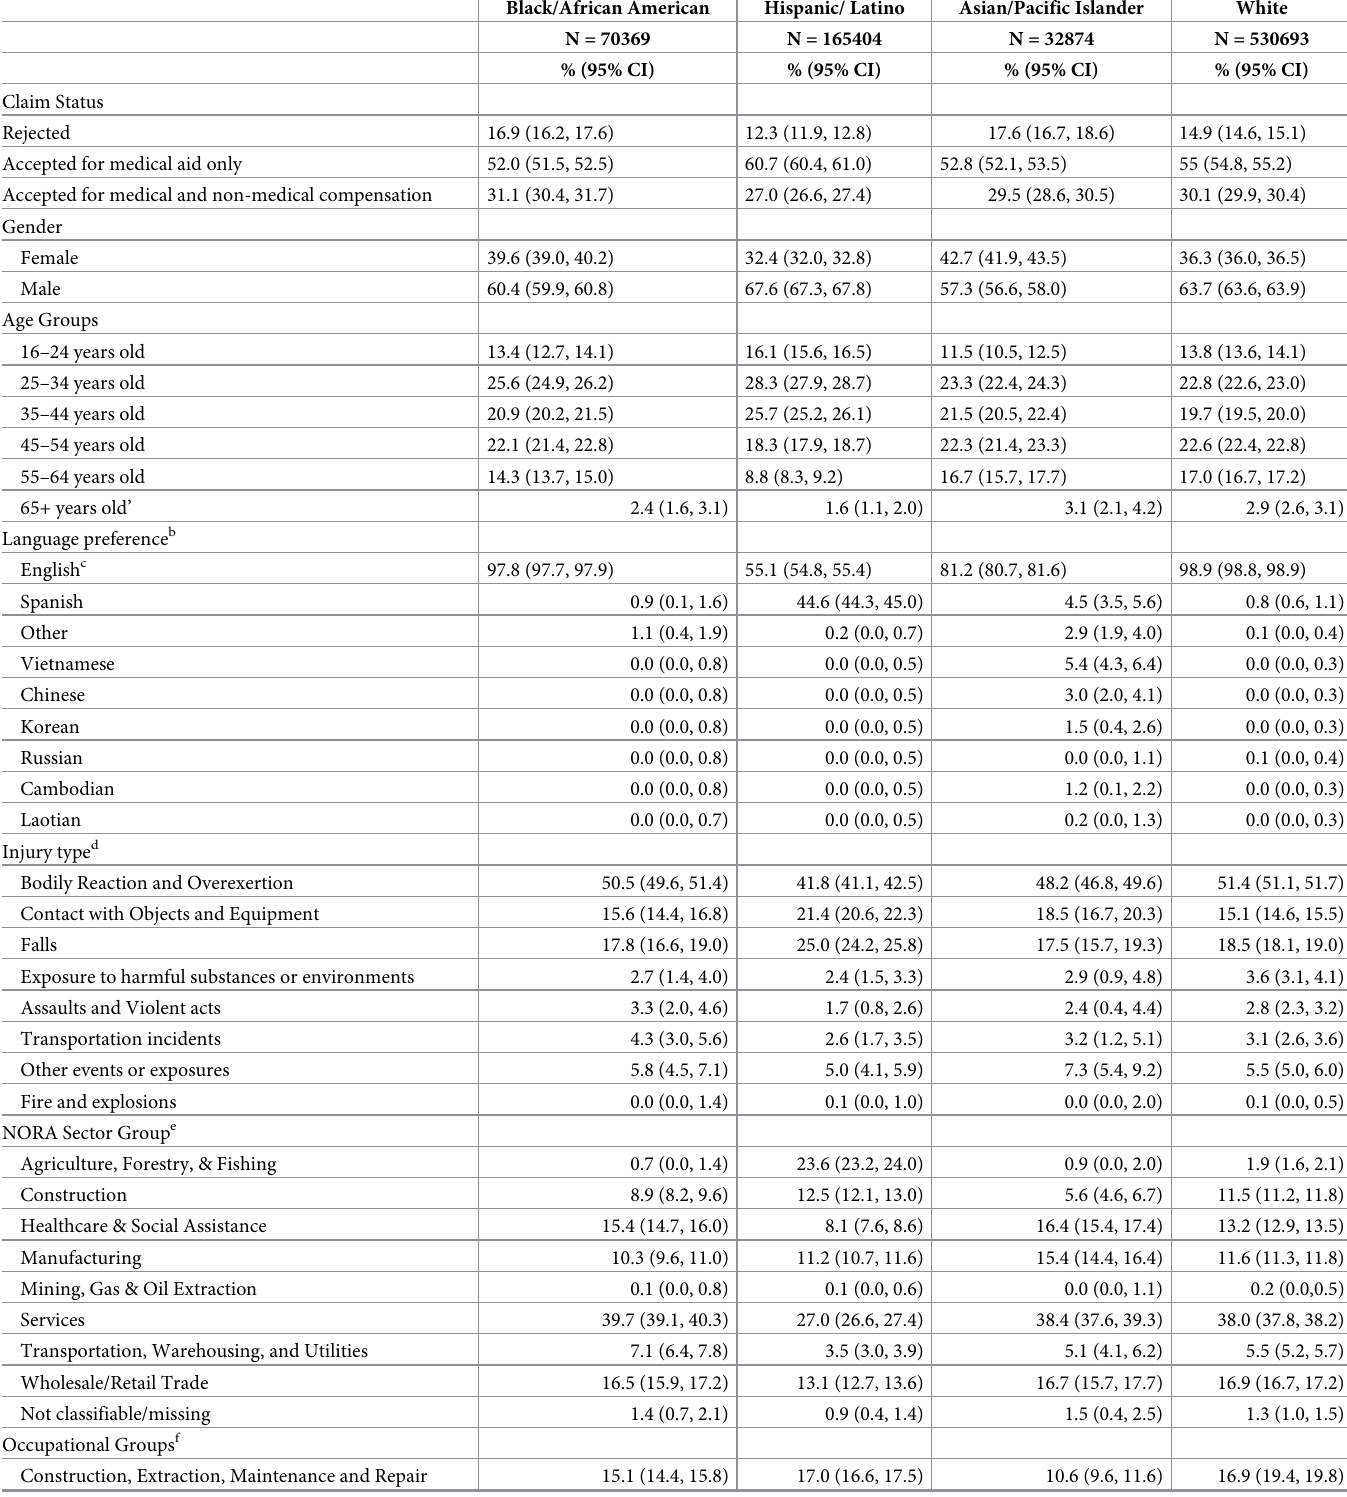
Table 1. Characteristics of all filed claims in Washington State 2013–2017 by estimated